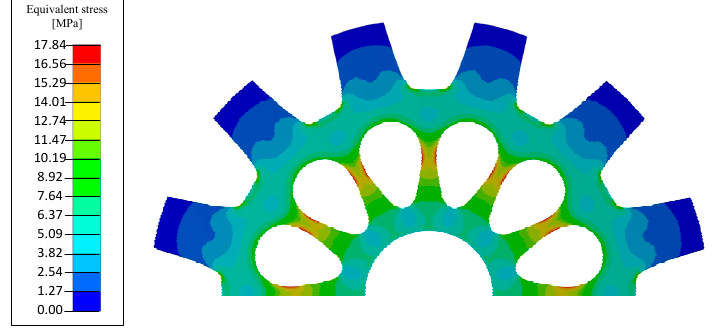
Figure 19. Von-Mises Stress analysis with rotor cutouts at 4500 rpm.